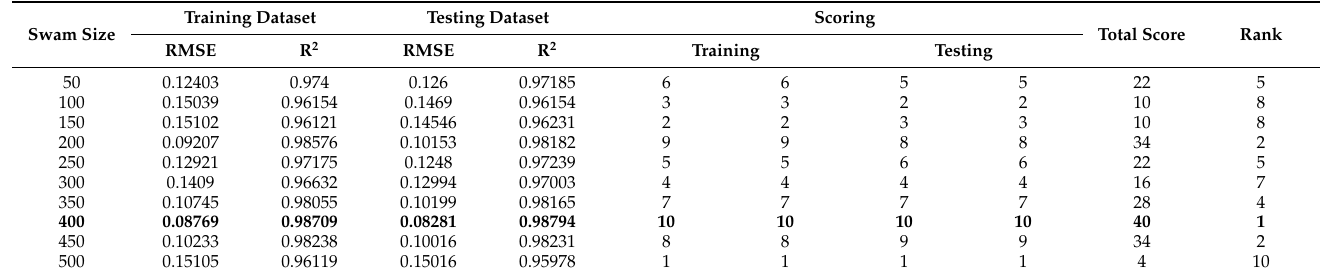
Table 2. The network results for the HHO − ANFIS having different swarm size.